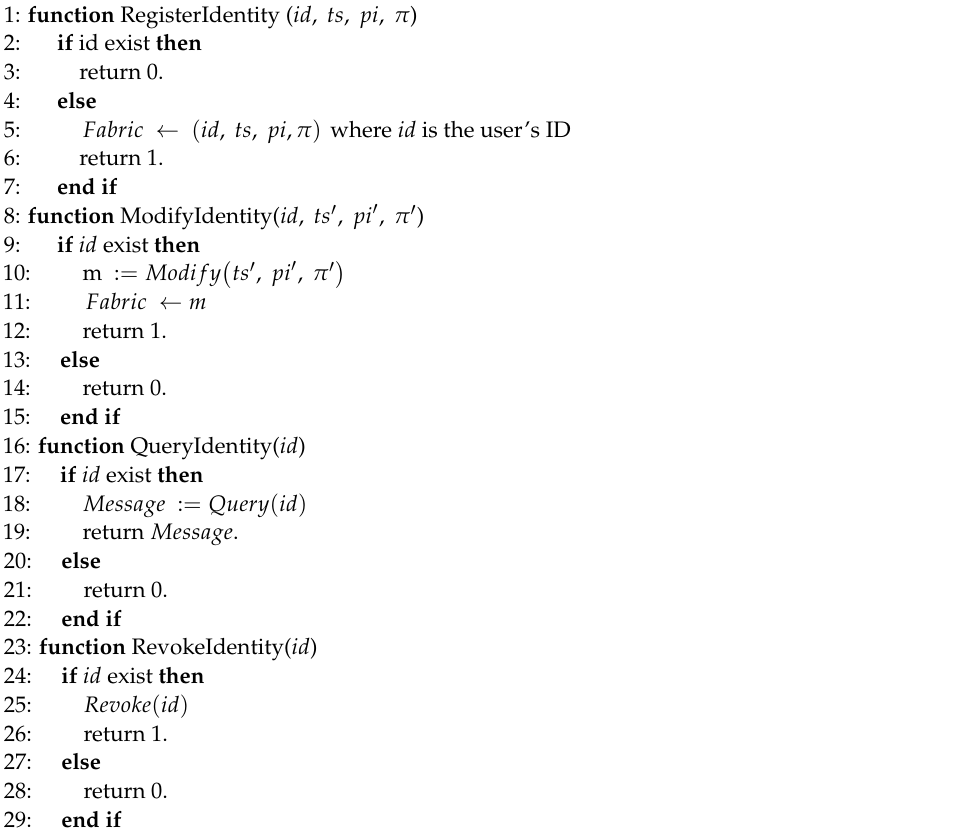
Algorithm 2 Chaincode